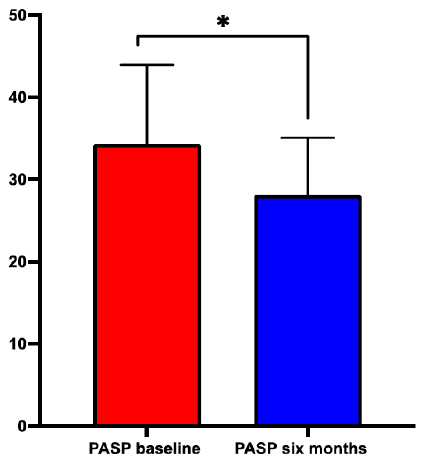
Figure 3. Example of the effects of CCM on TAPSE (panel ( A , C )) and S wave (panel ( B , D )) at six months follow-up.